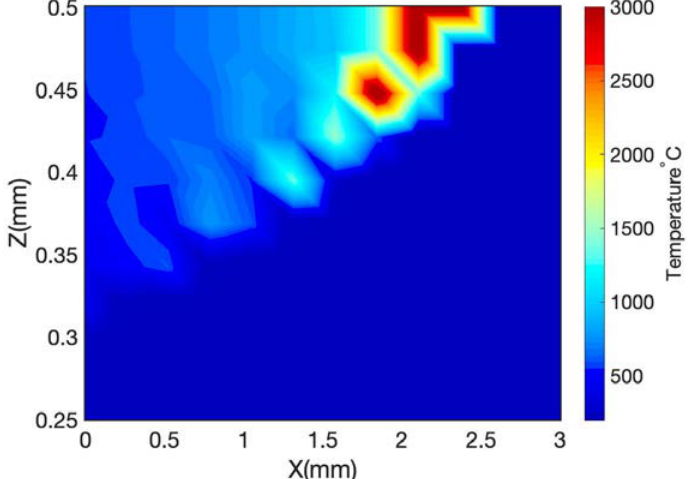
, and hatching space of 100 . µ m µ m